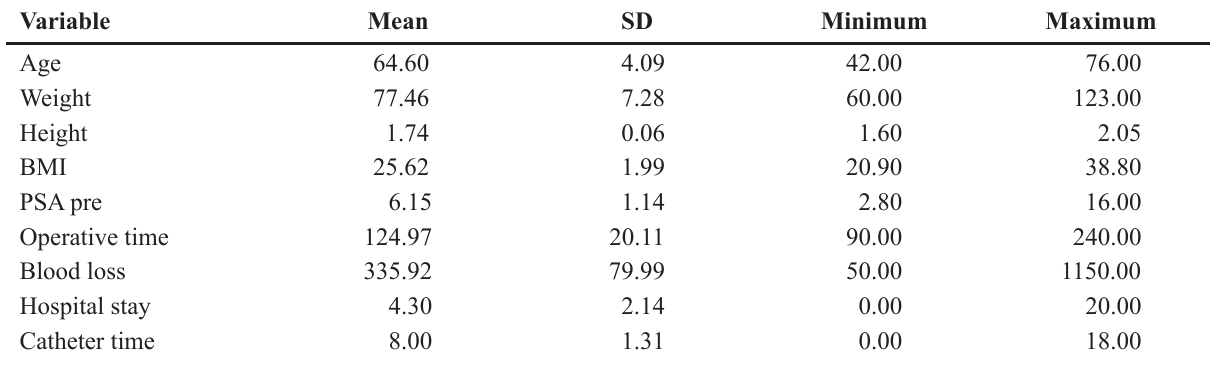
BMI = body mass index, PSA = prostatic specific